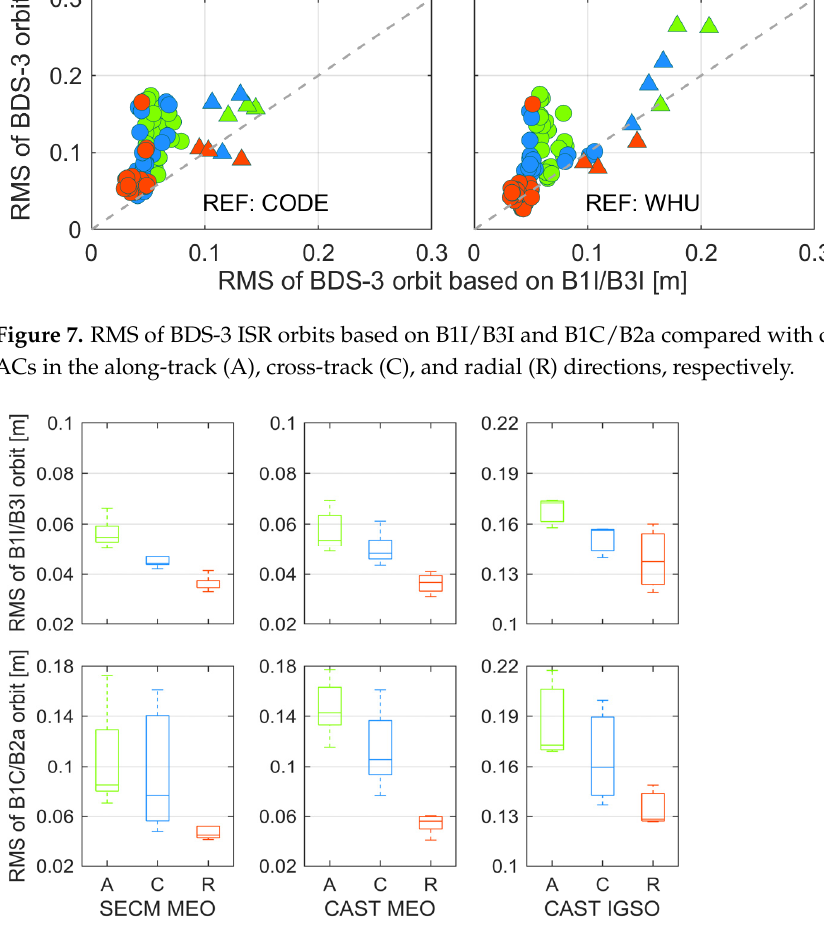
Figure 8. Box plot of RMSs of ISR orbits based on B1I/B3I and B1C/B2a in along-track, cross-track, and radial directions for SECM MEO, CAST MEO, and CAST IGSO satellites, respectively.